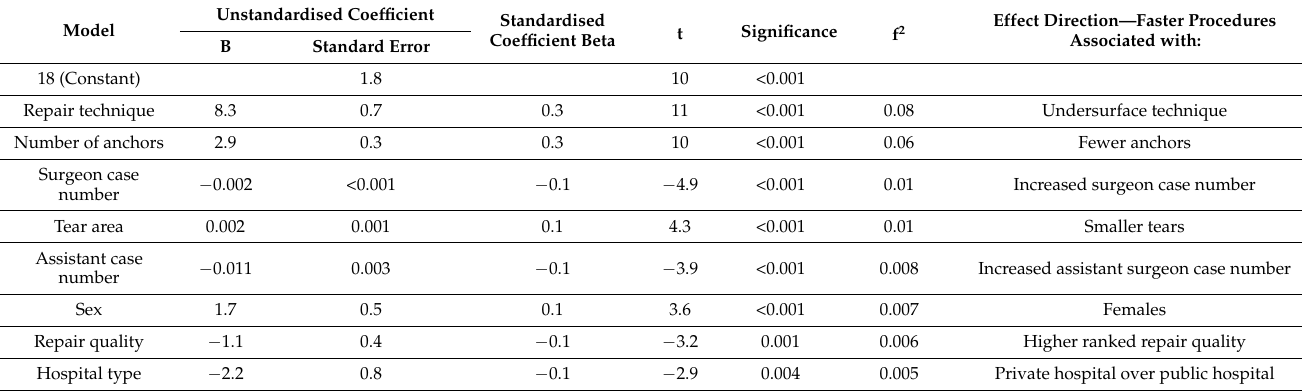
Table 2. Backwards multivariate linear regression against operative